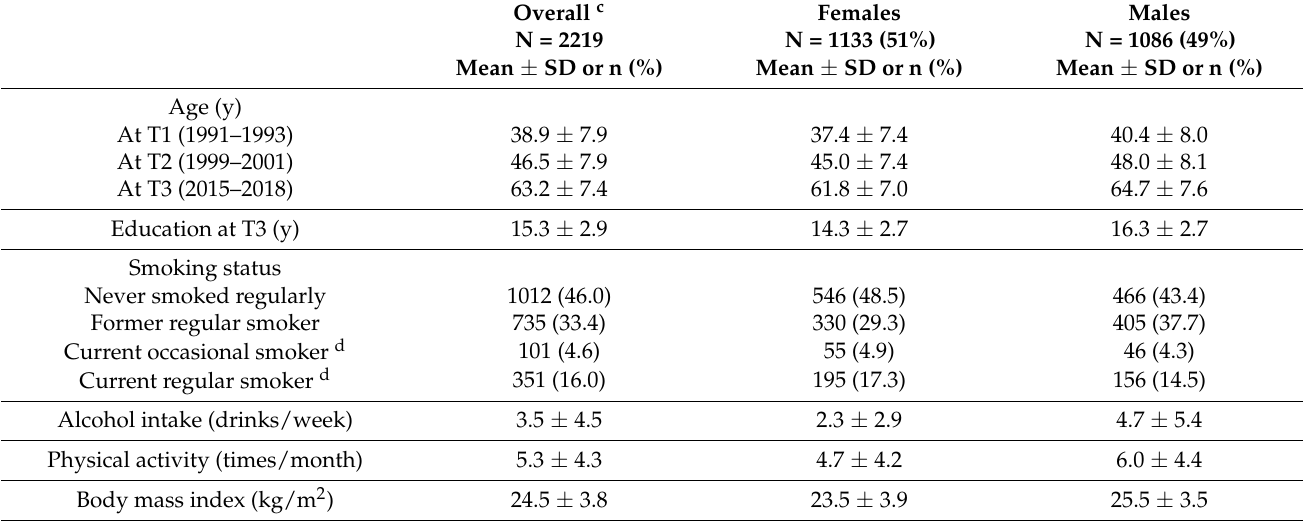
Table 1. Baseline characteristics a of the study sample b , overall and by